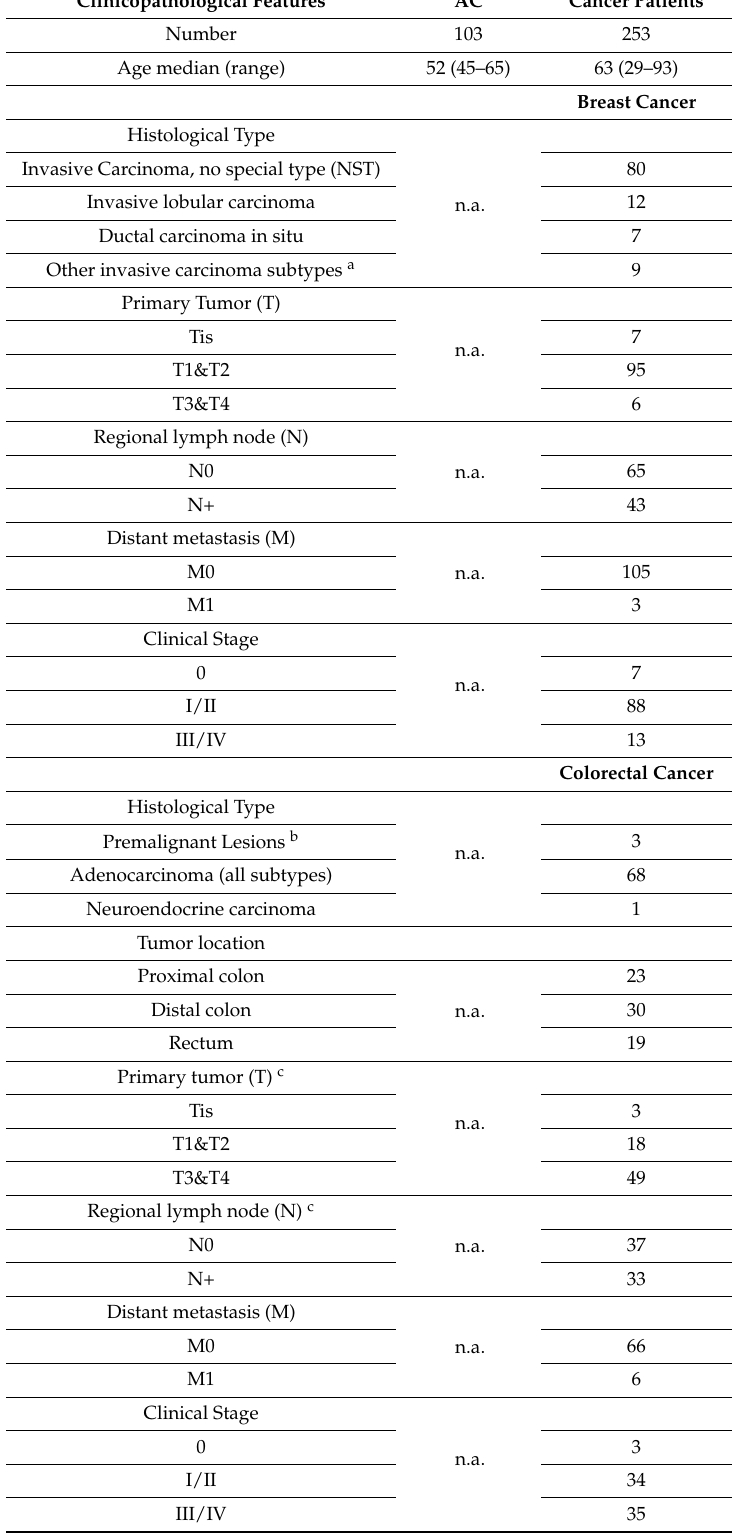
Table 1. Clinicopathological features of BrC, CRC and LC patients and ACs enrolled in this